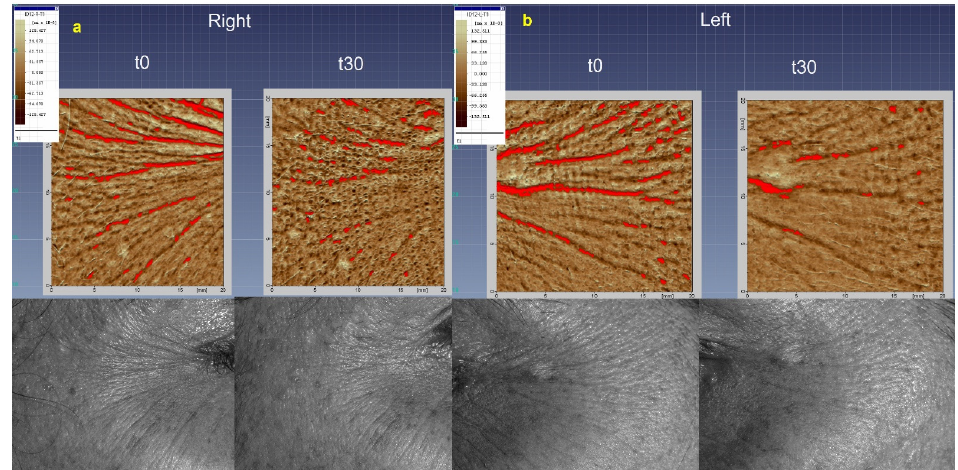
Figure 11. 3D DermaTop images (bottom part) and corresponding skin topography (upper part) at t 0 and t 30 days. ( a ) corresponds to the right side of the face where the formulation A was applied, and ( b ) corresponds to the left side of the face where the formulation B was applied. The reddish-colored regions indicate the depth of analyzed wrinkles.